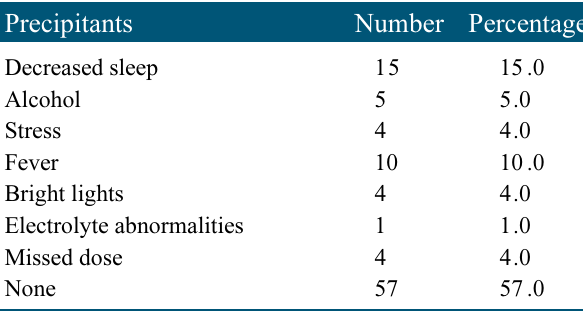
Table 3: Other characters of patients with seizure